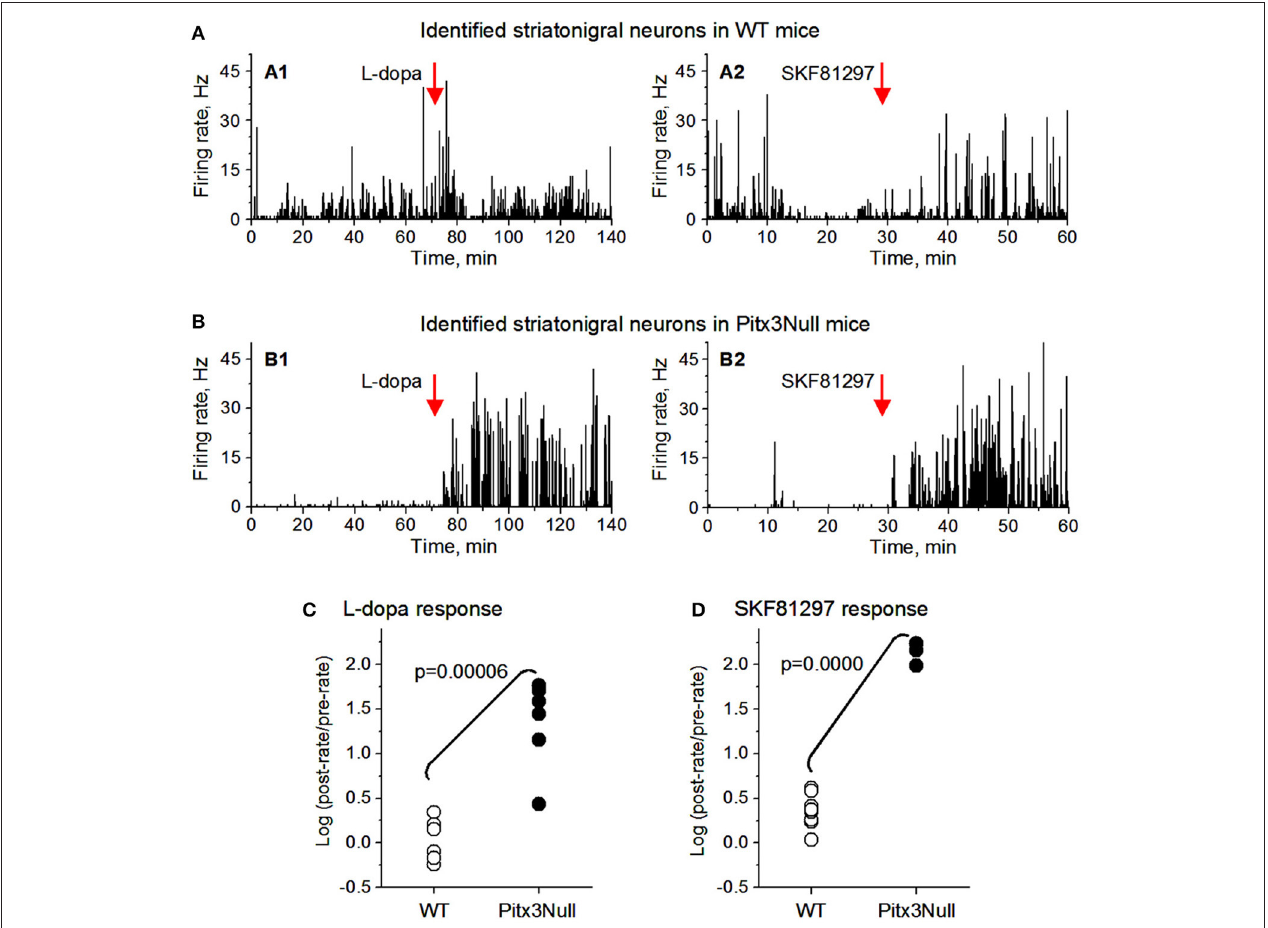
FIGURE 5 | Antidromically identified dorsal striatonigral neurons responded more strongly to dopaminergic stimulation in Pitx3Null mice than in WT mice. (A: A1,A2) : Two examplary antidromically identified dorsal striatonigral neurons each responded weakly to L-dopa or SKF, 81297 injection in WT mice. (B: B1,B2) : Two examplary antidromically identified dorsal striatonigral neurons each responded strongly to L-dopa or SKF, 81297 injection in Pitx3Null mice. (C) Scatter plot showing that the clearly stronger responses to L-dopa in identified striatonigral neurons in Pitx3Null mice than in Pitx3WT mice. (D) Scatter plot showing that the stronger responses to SKF, 81297 in identified striatonigral neurons in Pitx3Null mice than in Pitx3WT mice. p values were obtained from unpaired t